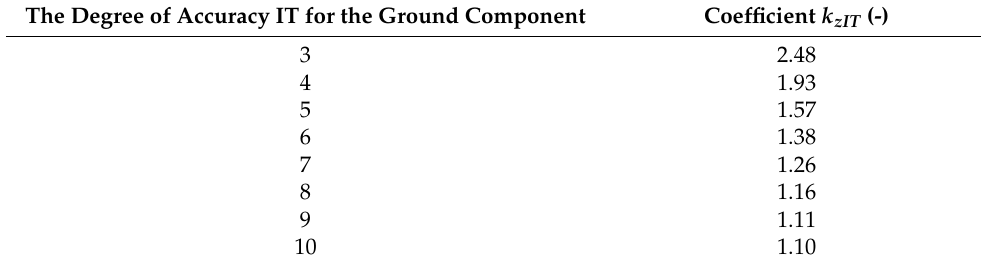
Table 4. Coefficient k zIT